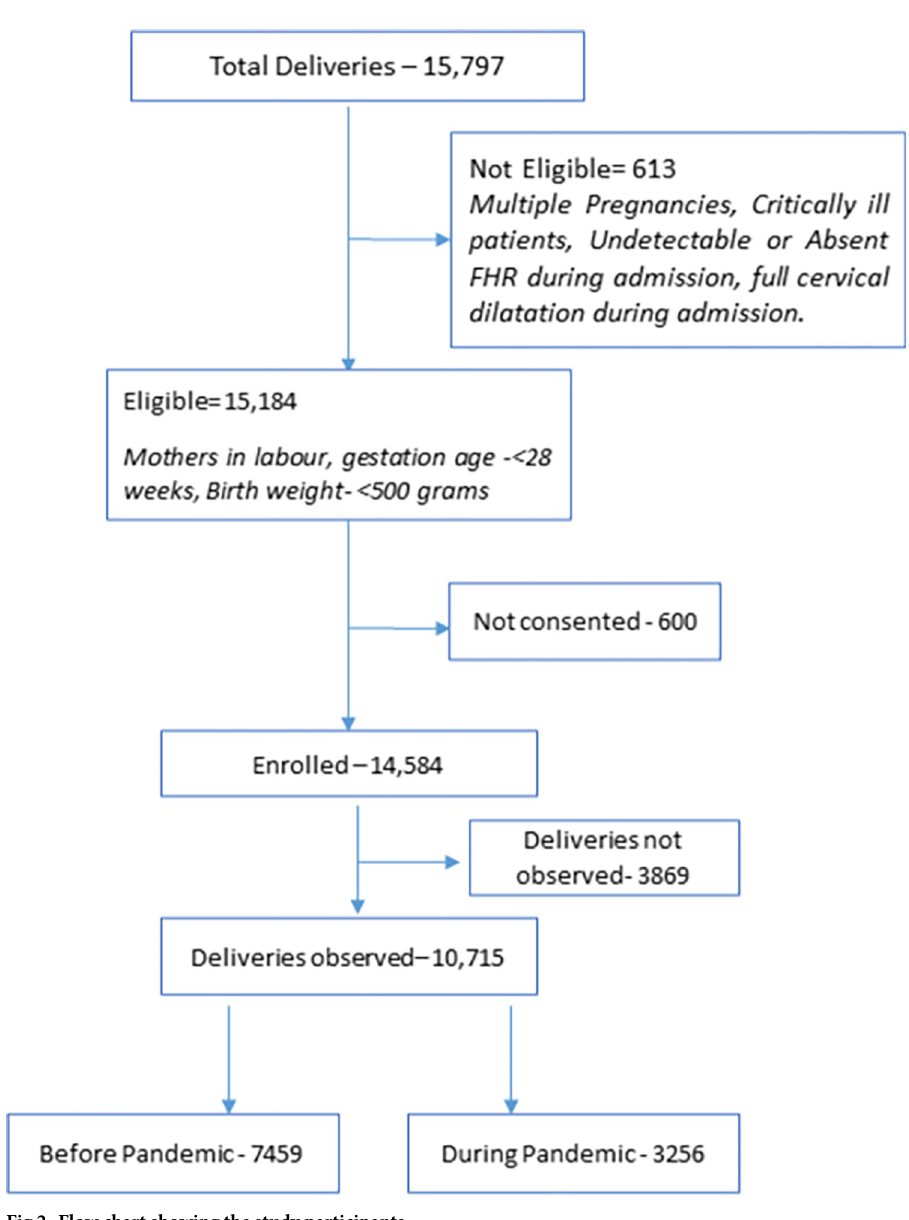
Fig 2. Flow chart showing the study participants. born preterm (before 37 weeks) increased from 4.6% before pandemic to 6.4% during the pan- demic; (p < 0.0001) and there was an increased proportion of the babies born low birth weight during the pandemic (8.1% vs 10.2%, p < 0.0001) (Table 3). Overall, the frequency of intrapartum FHR monitoring when compared to pre-pandemic period increased during the pandemic (p < 0.0001). Monitoring and documentation of intra- partum FHR in an interval of less than 30 minutes increased from 47% in pre-pandemic period to 73.3% during the pandemic (p < 0.0001). Among women whose intrapartum FHR was detected abnormal during labor, an increased proportion of women had their FHR monitored as per protocol during pandemic (when compared with pre-pandemic period (59.3% vs 20.0%,